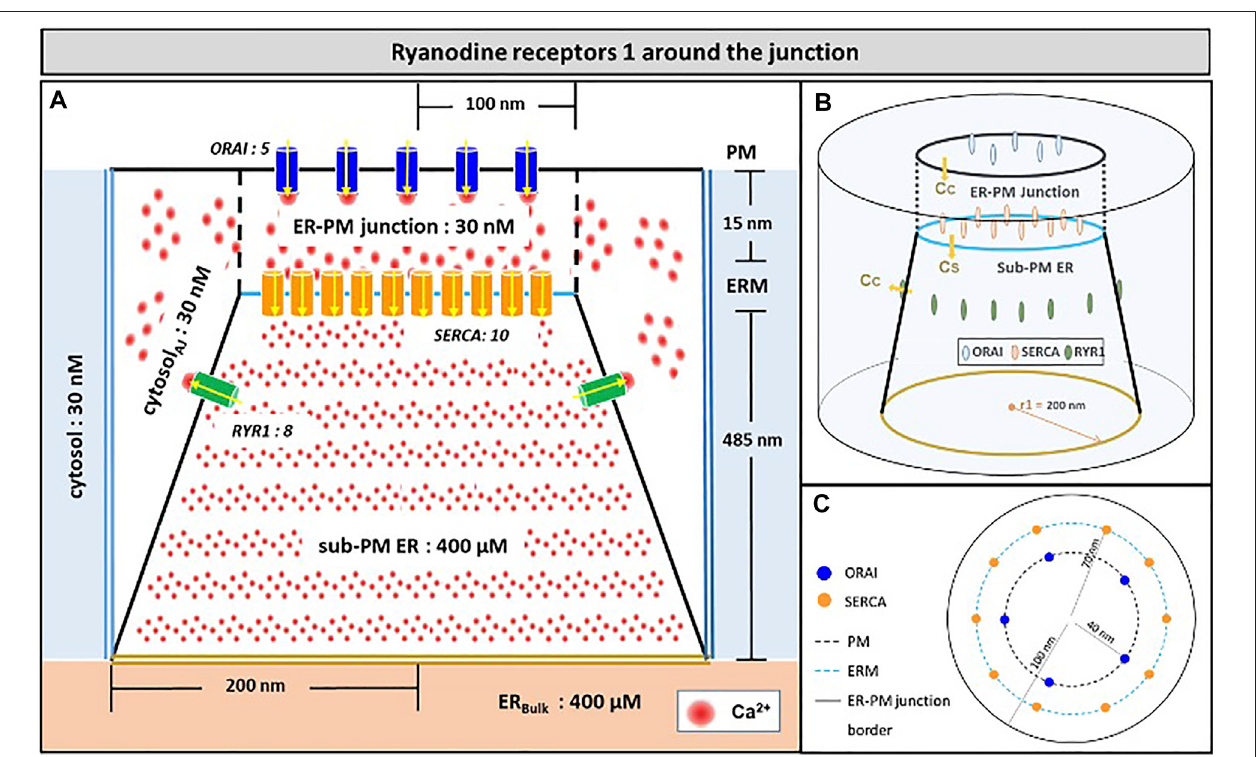
FIGURE 4 | Schematic representation of the model geometry of the ER-PM junction and sub-PM ER used to investigate the origin of the Ca 2+ microdomains in T cells with eight RYR1 around the junction (A) Frontal diagram showing the dimensions of the cone that represents the sub-PM ER, of the junction and of the portion of thecytosolconsideredinthesimulations.ORAI1channelsareinblue,SERCApumpsinorangeandRYR1ingreen.Plainlinesrepresentmembraneboundaries;dashed lines, fi ctitious limits between the junction and the cytosol and double lines indicate the limits of the simulated system. The resting Ca 2+ concentrations considered as initial conditions and boundary conditions in the two compartments are indicated. (B) 3D view of the model geometry (C) Upper view of the positions of the ORAI1 channels on the PM, in blue, and of the SERCA pumps and RYR1 on the ERM, in orange and green respectively. Not to scale. This geometry is based on McIvor et al. (2018). See text for